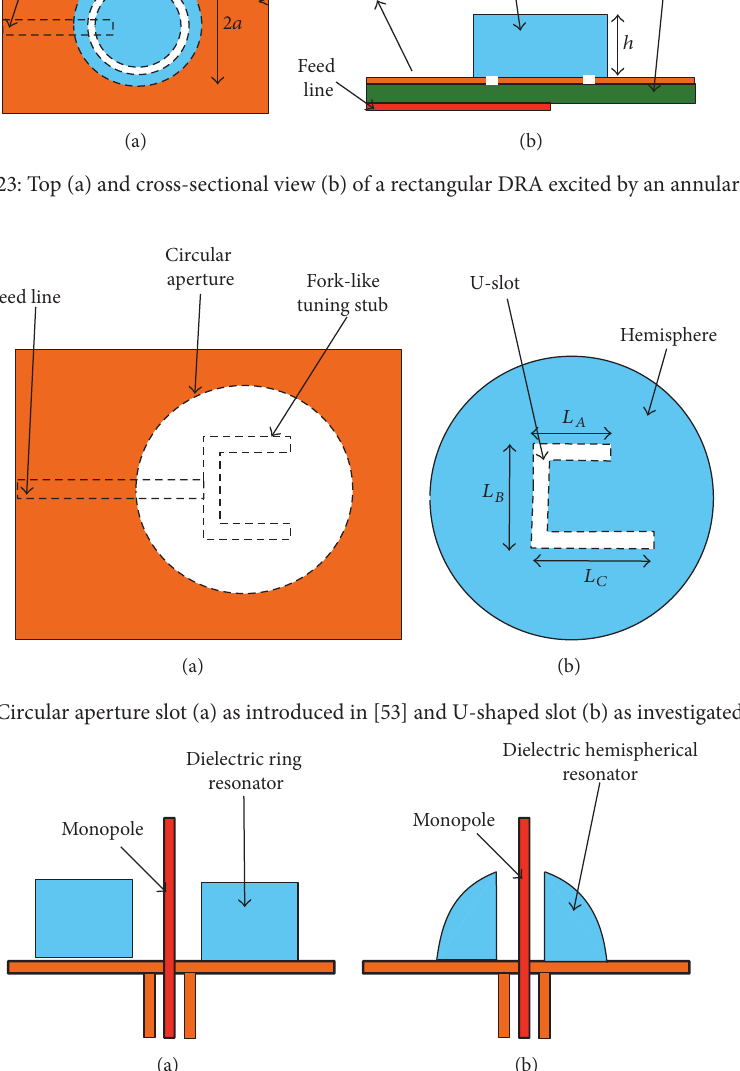
Figure 25: Cross-sectional view of a hybrid DRA consisting of a monopole and a ring DR (a) as suggested in [56]. Cross-sectional view of a hybrid DRA consisting of a monopole and a conical DR (b) as suggested in